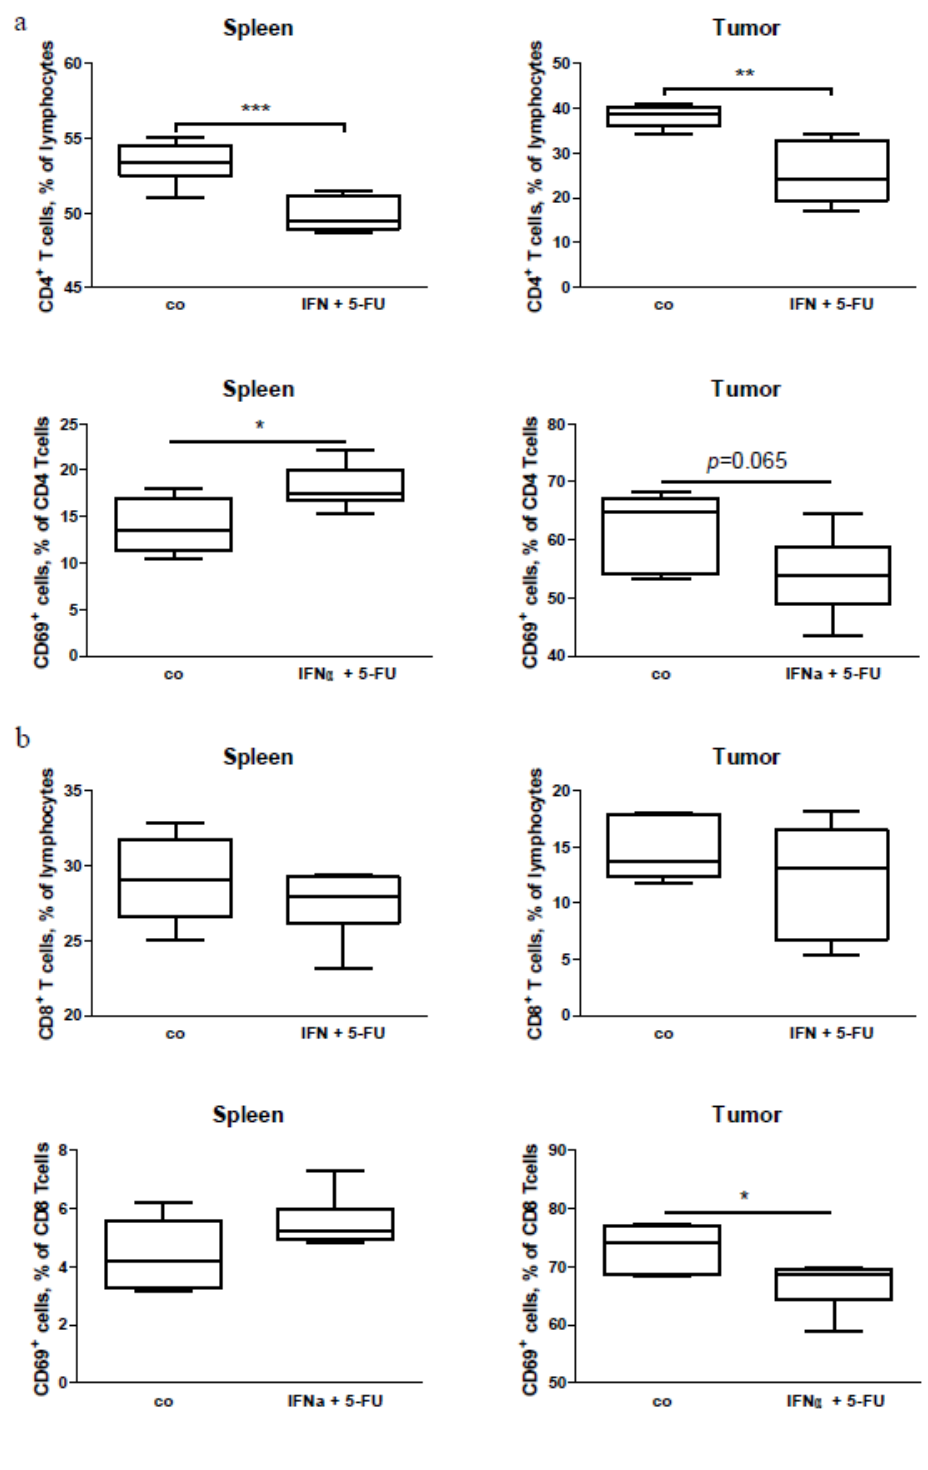
Figure 5. FACS analysis of lymphocytes in the spleen and tumors of Panc02-bearing mice treated with a combination of IFN and 5-FU (IFN + 5-FU), and of control-treated animals (co). ( a ) CD4 + T cells and their activation; ( b ) CD8 + T cells and their activation in the spleen and tumors of Panc02 tumor-bearing mice, respectively. Six to eight animals per group, * p < 0.05, ** p < 0.01 and *** p <